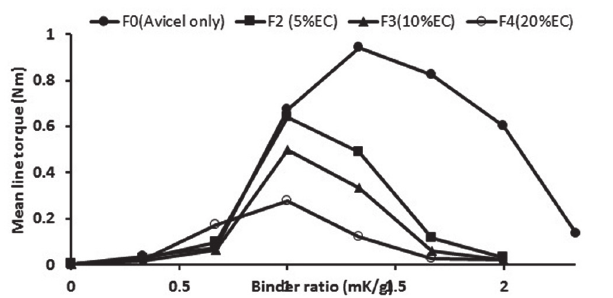
FIGURE 1 - Effect of different concentrations of EC on mean torque of Avicel PH101 ® wet masses.